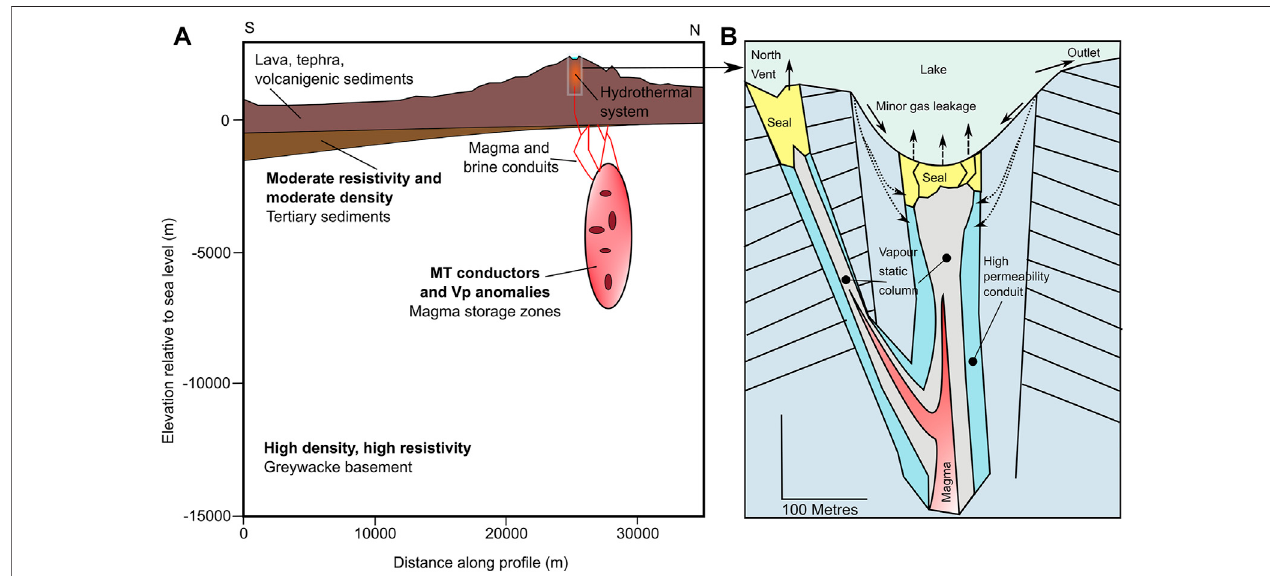
FIGURE 4 | Mt Ruapehu volcano conceptual model on two scales. (A) South to north cross section showing crustal setting of Mt Ruapehu and locations of basement,magmaandhydrothermal systeminferredfromgeologicalmappingandgeophysicalsurveys(modi fi edafterLeonardetal.(2021)).Theboxaroundthecrater lake region is shown in detail in part (B) . (B) Generalised components of the hydrothermal system beneath the crater lake (modi fi ed after Christenson et al. (2010)).